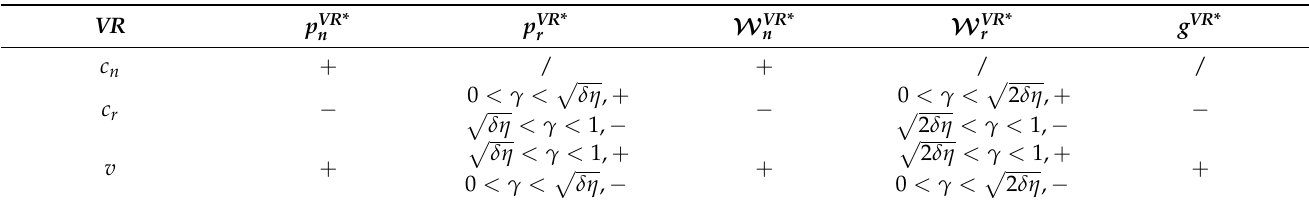
Table 4. The influence of the change in each parameter on the optimal decision under the decentral- ized decision-making model (VR